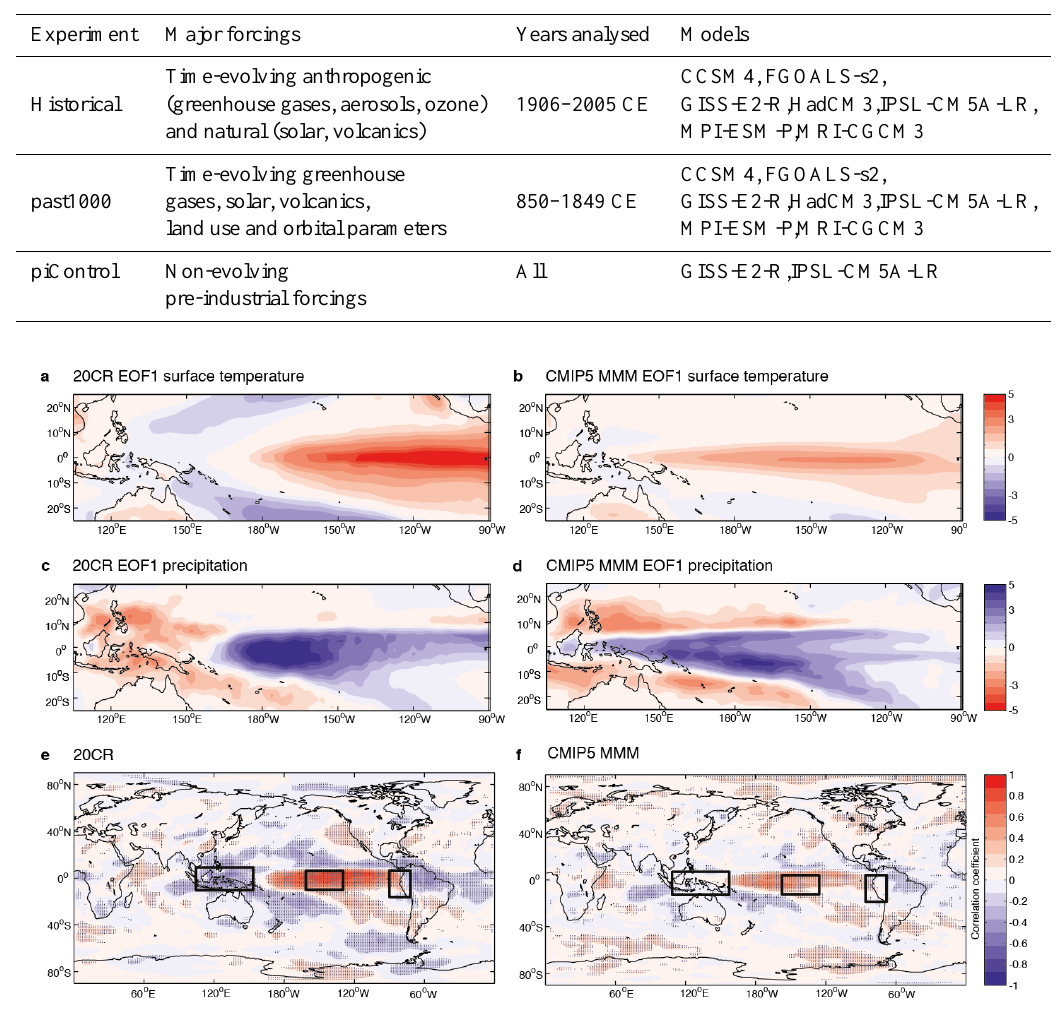
Figure 3. Comparison of leading patterns (standardised, first EOFs) of monthly variability in surface temperature and precipitation for 20CR reanalysis (left: a , surface temperature; b , precipitation), CMIP5 models ( b , surface temperature; d , precipitation). CMIP5 historical patterns are the multi-model mean (MMM) of the first EOF of each individual model for model years 1976-2005. Spatial correlation coefficients between NINO3.4 index and 20CR precipitation (e) and the CMIP5 MMM (f) . Stippling indicates Spearman’s rank correlations significant at the 95% level. Rectangular boxes indicate the East, Central and West Pacific regions. Only model years 1976–2005 are used for comparison as the historical experiment necessarily produces a non-stationary climate due to the time-evolving anthropogenic greenhouse gas forcings